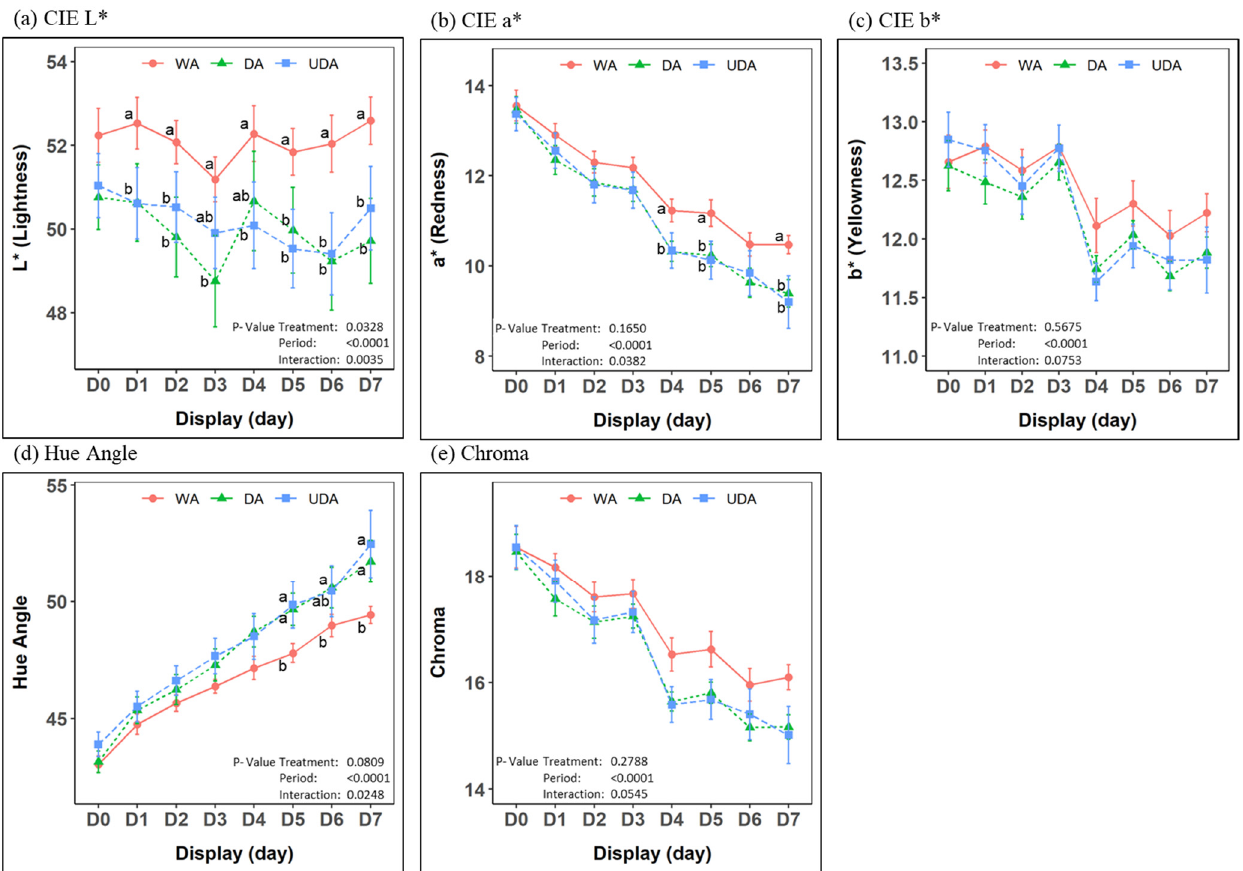
Figure 1. Effect of different aging treatments on the instrumental color characteristic of pork loins ( M . Longissimus lumborum ) aged for 21 days during 7 days of display period. Different aging treatments: wet-aging (WA), conventional dry-aging (DA), and UV-light dry-aging (UDA). a,b Means with different letters indicate significant differences within the same display day ( p < 0.05). ( a ) CIE L*; ( b ) CIE a*; ( c ) CIE b*; ( d ) Hue Angle; ( e )